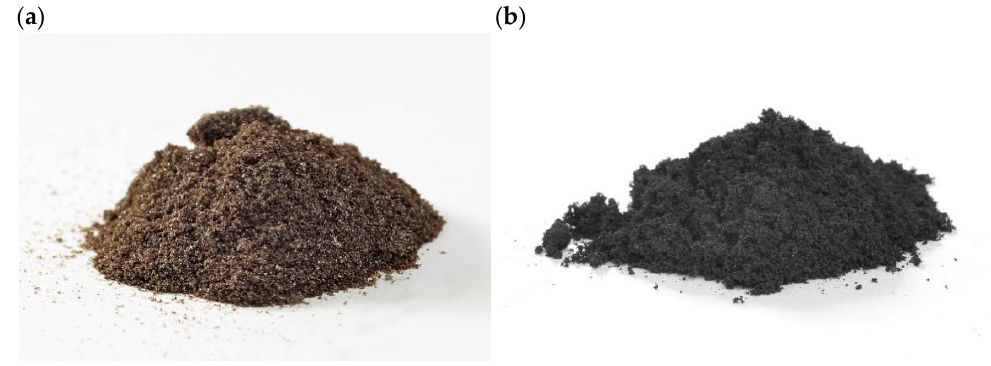
Figure 1. Graphene materials used in the tests: ( a ) graphene oxide, ( b ) reduced graphene oxide. Graphene oxide was produced using a modified Hummers method. This method is based on the oxidation of flake graphite (Asbury Carbons, Asbury, NJ, USA) in sulfuric acid VI (96%, pure p.a., Chempur, Poland) with the addition of potassium permanganate (pure p.a., Chempur, Piekary Śląskie, Poland) and potassium nitrate (pure p.a., Chempur, Poland). After the oxidation process, the graphite oxide in the form of an aqueous suspension is exfoliated and then purified by filtration. After the purification process, an aqueous suspension of graphene oxide is obtained. In order to produce reduced graphene oxide,